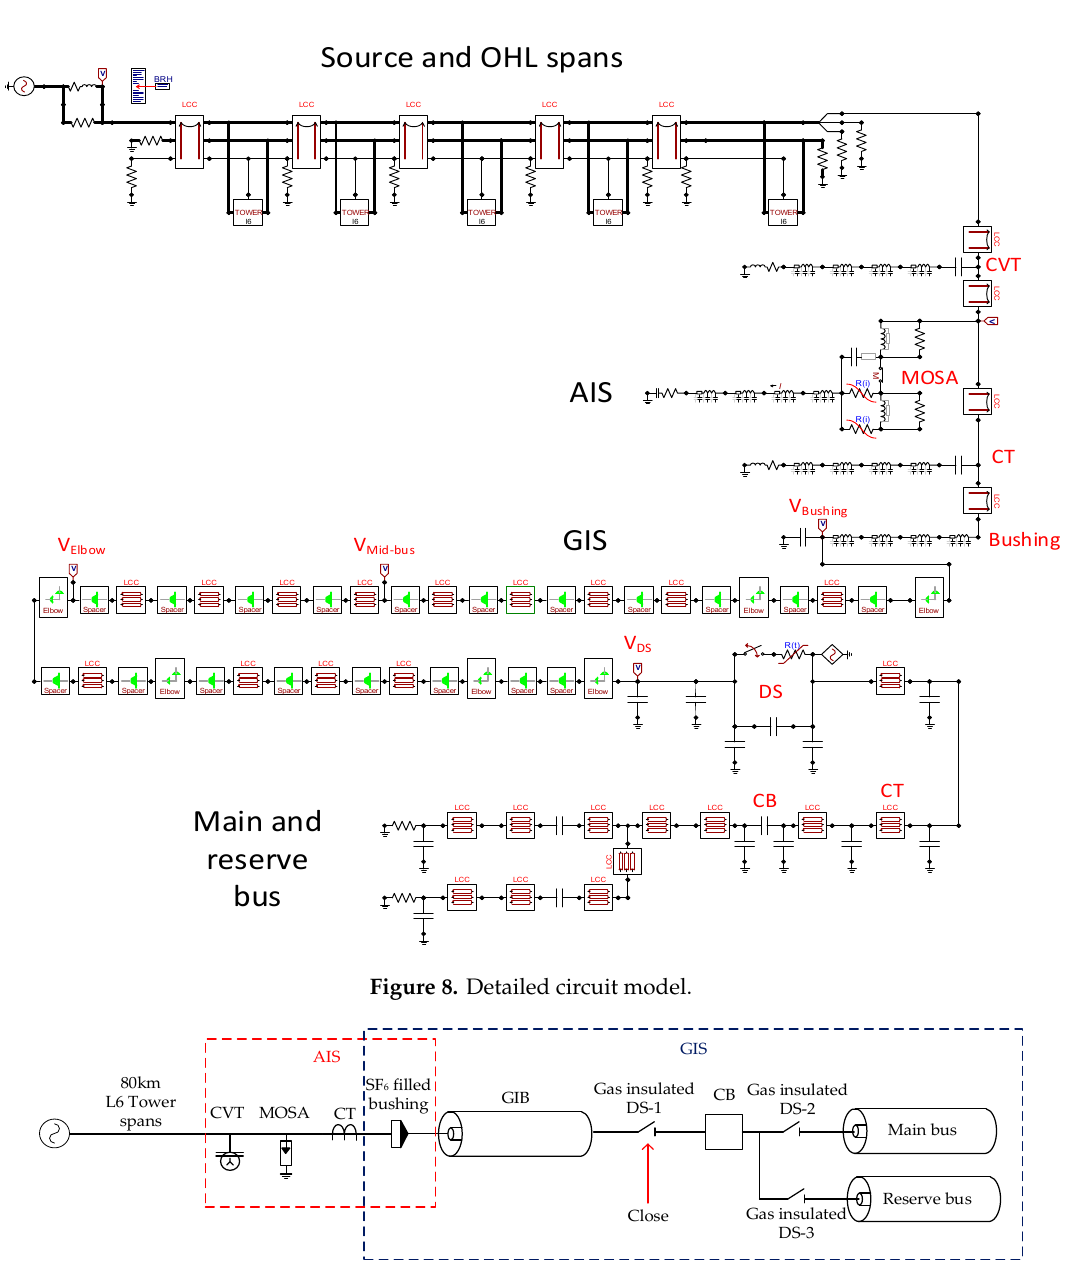
Figure 9. 400 kV system diagram. Table 3. Circuit model components.